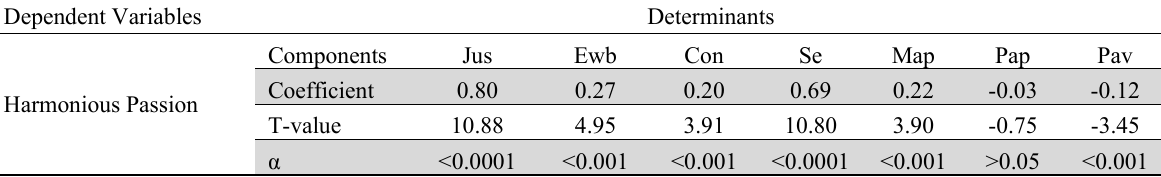
Total Effect of Direct and Indirect Determinants of Harmonious Passion Dependent